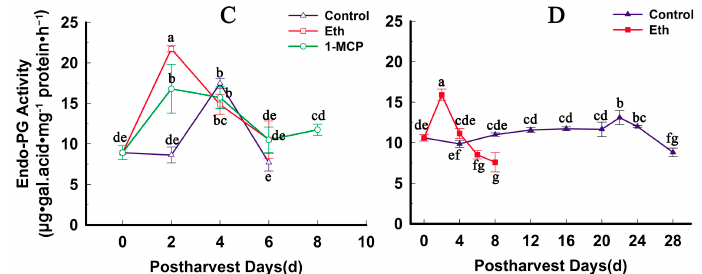
Figure 6. Exo-PG and endo-PG activity of control and ethylene-treated fruits during storage in two peach cultivars: ( A ) QJB exo-PG activity; ( B ) QW exo-PG activity; ( C ) QJB endo-PG activity; and ( D ) QW endo-PG activity. Data are the means ± standard errors ( n = 3). Significant differences ( p < 0.05) between means are indicated by different letters.